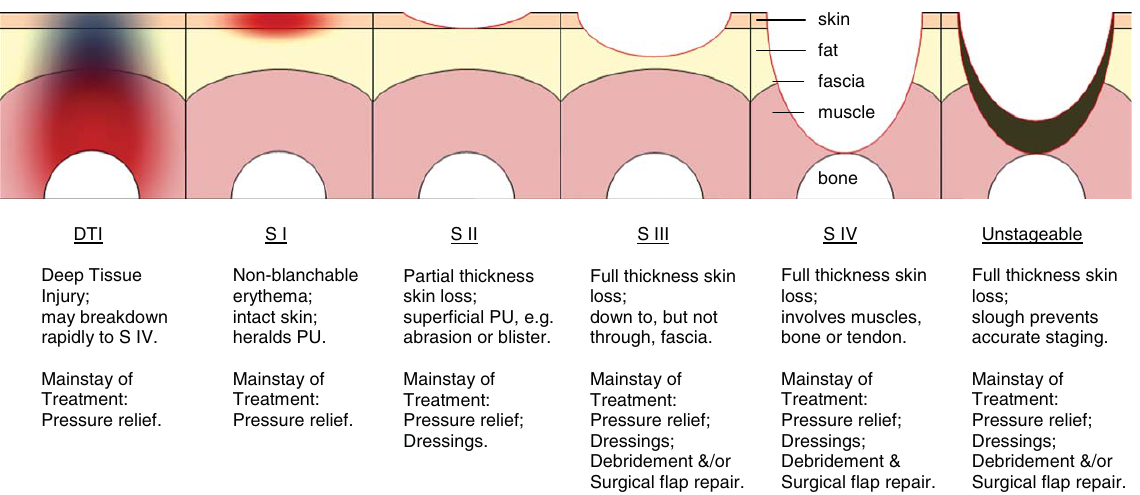
Fig. 1. Author’s representation of the National Pressure Ulcer Advisory Panel (NPUAP) PU staging system (NPUAP